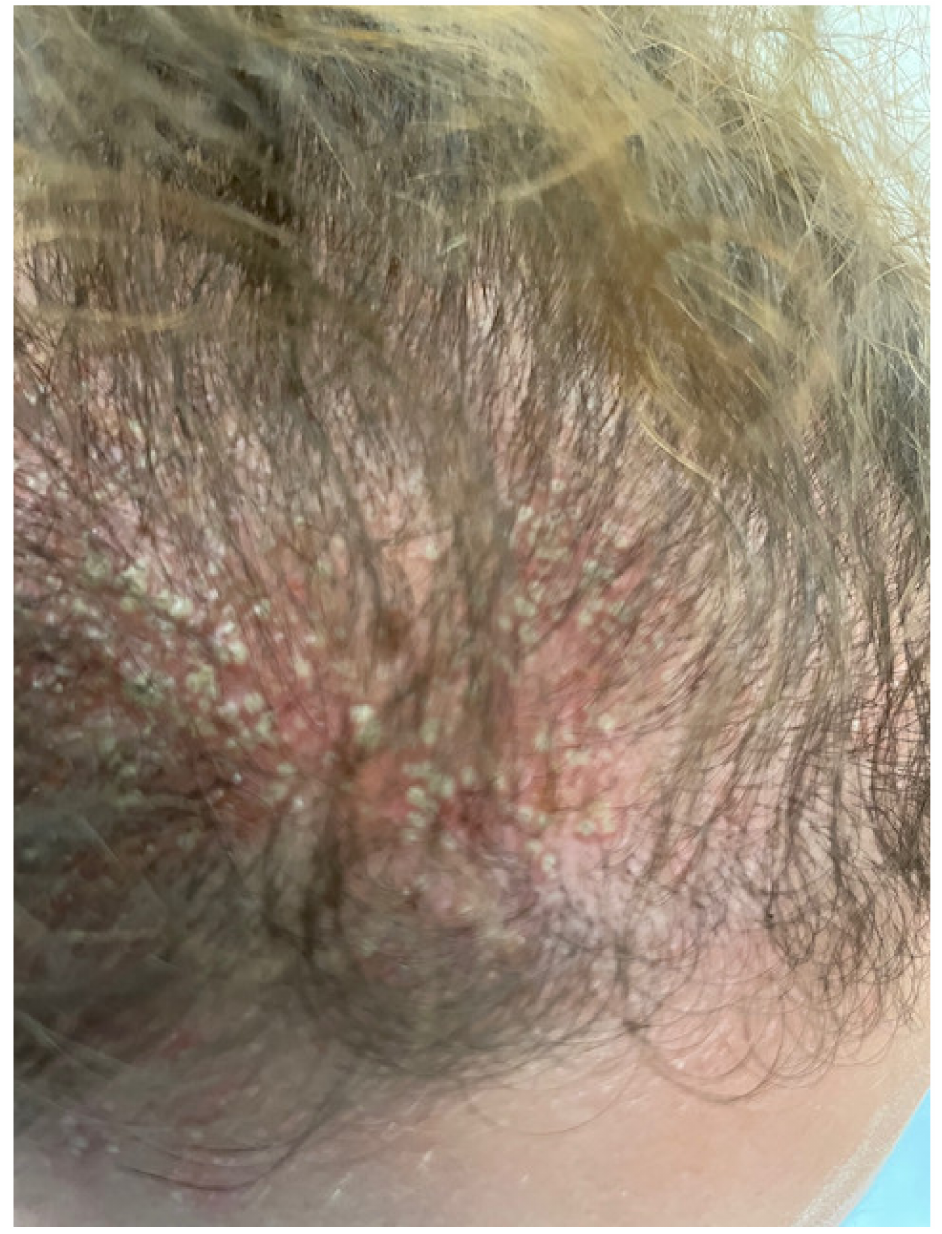
Figure 2. Presence of multiple non-follicular pustules on an erythematous base distributed on the